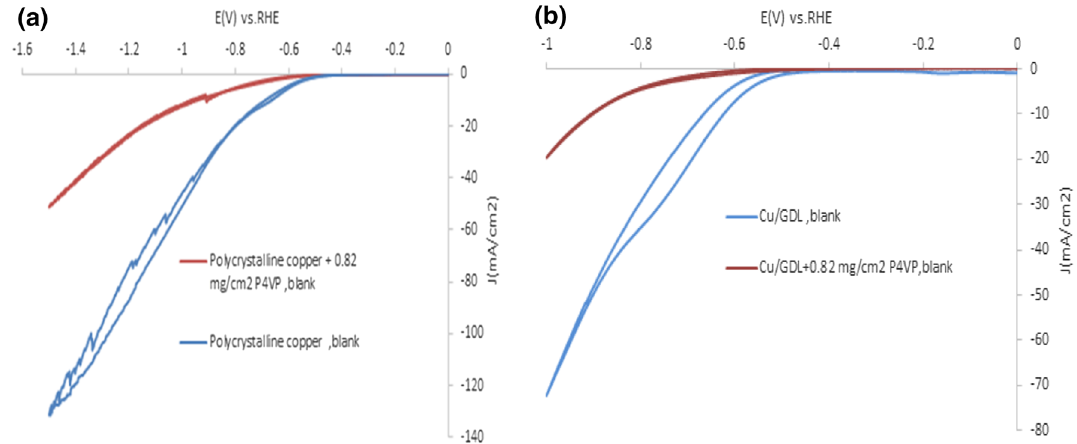
Fig. 3 CV curve of polycrystalline copper and Cu/GDL before and after P4VP loading in 1 M KHCO 3 electrolyte at pH 6.7. a Polycrystalline copper, blank electrolyte. b Cu/GDL, blank electrolyte. Scan rate: 50 mV/s